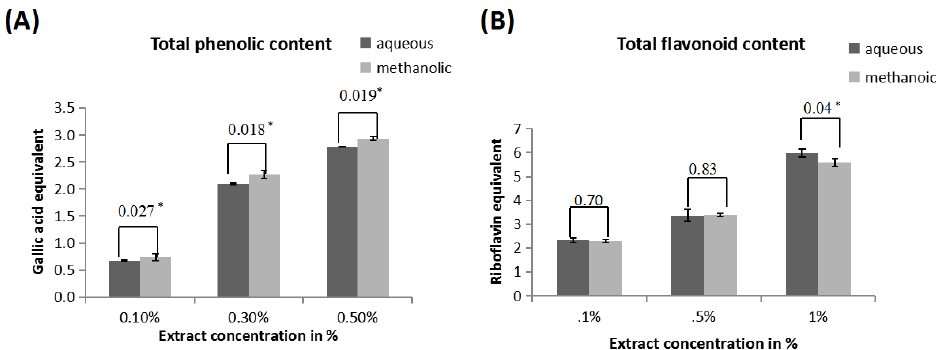
Figure 1. ( A ) Total phenolic contents of different concentrations of aqueous and methanolic extracts of A. catechu (0.1%, 0.3% and 0.5%) was measured and expressed in terms of mg of gallic acid equivalents per g of powder. ( B ) Total flavonoid content of different concentrations of aqueous and methanolic extracts of A. catechu (0.1%, 0. 5% and 1%) was measured and expressed in terms of mg of riboflavin equivalents per g powder. * Statistically significant ( p ≤ 0.05).